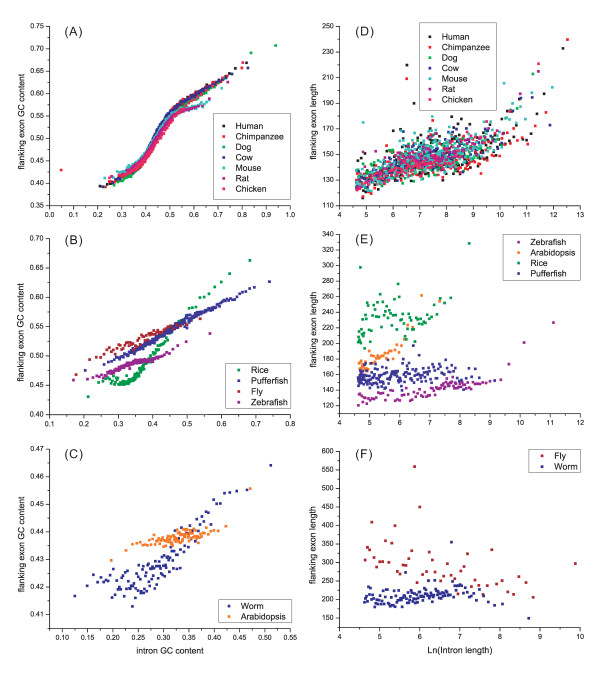
Variation patterns of exon GC content, as a function of flanking intron GC content (A~D), and exon length, as a function of flanking logarithmical intron length (E~H). Each dot contains 1000 introns and 1000 exons (1000 left exons flanking the corresponding introns). Introns used in E~H are > 100 bp.